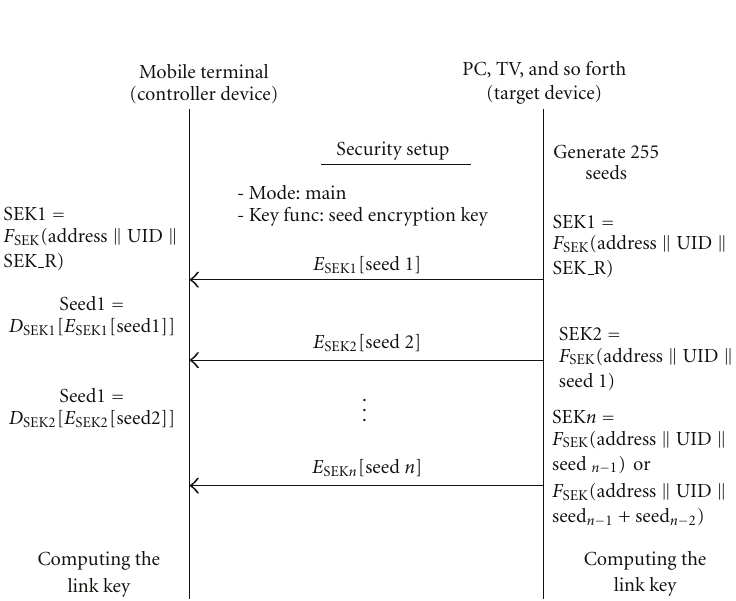
Figure 6: Key seed distribution-quick mode.